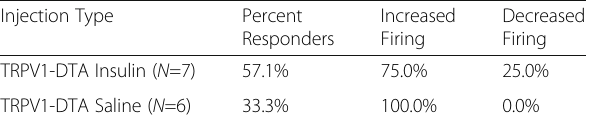
Table 2 Population results of the detected responders on all injection experiments for TRPV1 cell depleted mice. Insulin injections elicited a response 57.1% of the time and tended to cause an increased rate of firing. Saline injections elicited a response 33.3% of the time